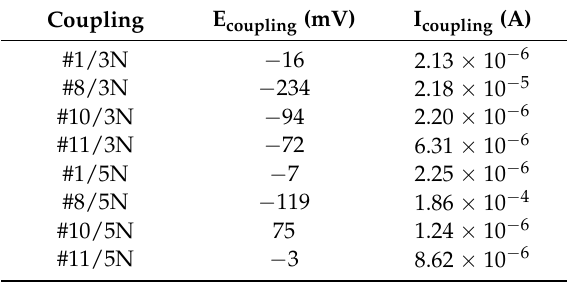
Table 9. Values I coupling and E coupling calculated according to the mixed potential theory.